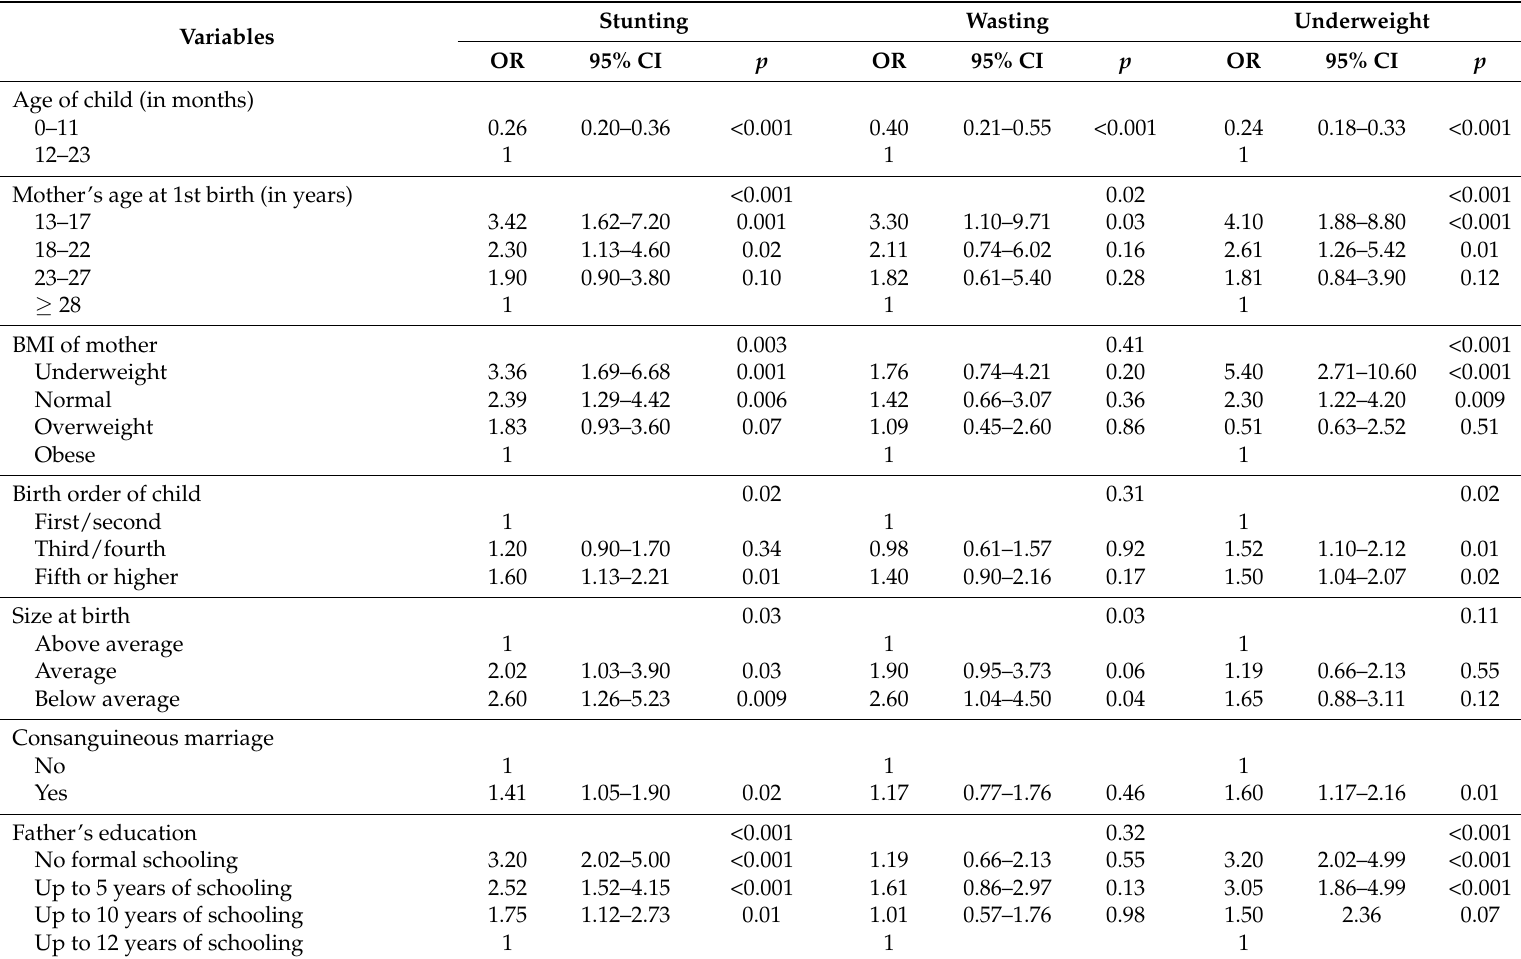
Table 3. Binary logistic regression for factors associated with stunting, wasting, and underweight in children under two years of age. Stunting Wasting Variables